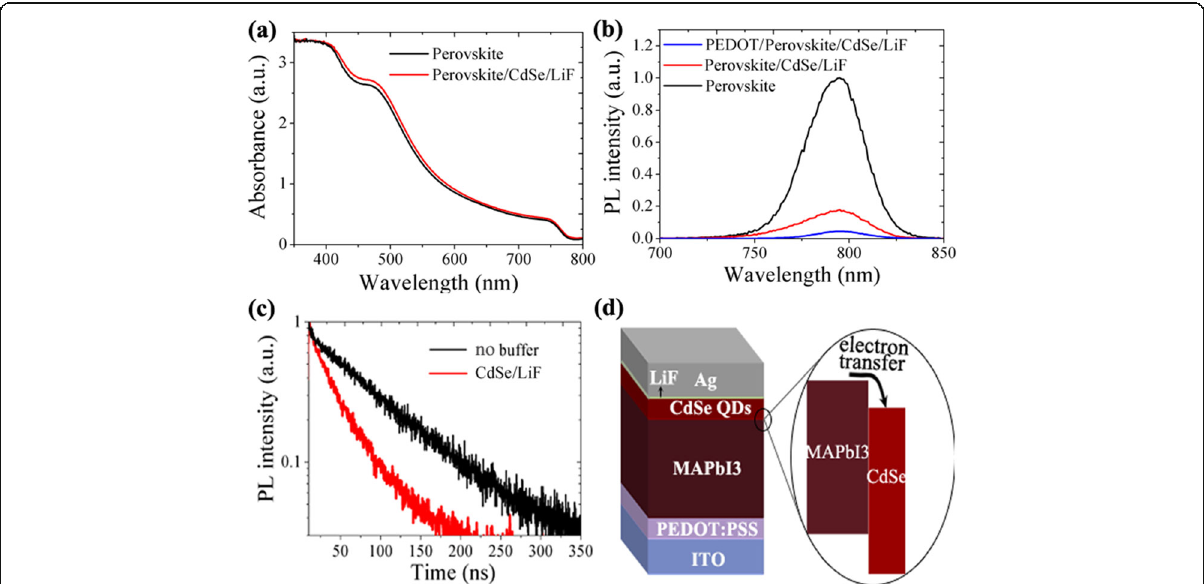
Fig. 2 Light absorption ( a ), photoluminescence ( b ), and time-resolved PL spectrum of the perovskite films with and without ETL layer ( c ). Device